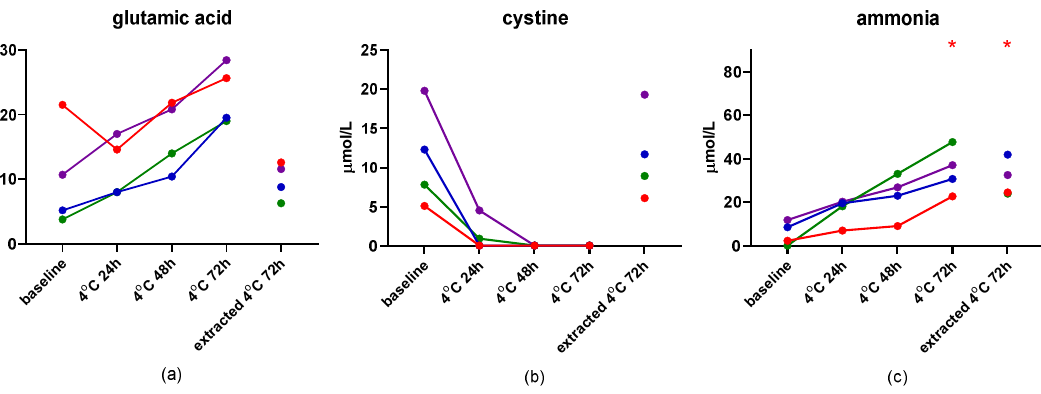
Figure 2. Stability of serum concentrations of glutamic acid ( a ), cystine ( b ), and ammonia ( c ) in naïve serum stored at 4 °C for up to 72 h and deproteinized serum stored for 72 h. Red asterisks indicate significance ( p < 0.05) compared to baseline.